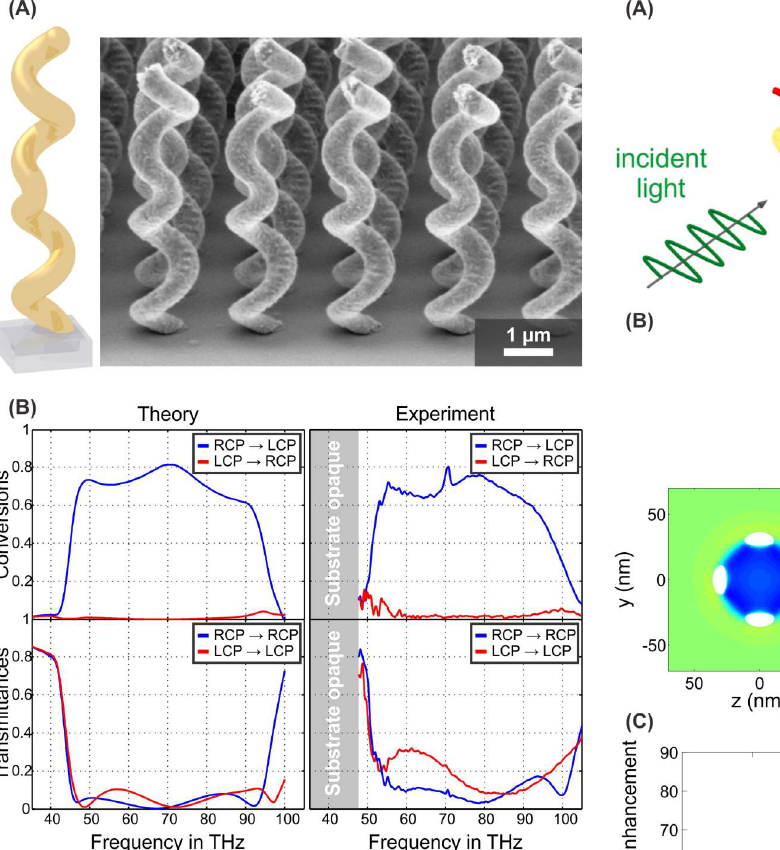
Figure 9: (A) Illustration of the circular polarization converter de- sign. A left-handed gold helix on the top is followed by a right- handed gold helix, each of which has 1.5 pitches. The scanning electron micrograph on the right depicts an array fabricated via STED-inspired direct laser writing. (B) Numerical calculations and experimental data for all four entries of the Jones matrix in circular polarization basis. Polarization conversions are depicted in the top, polarization-conserving transmittances in the bottom row (adapted with permission from [65]. Copyright 2015 John Wiley and Sons).